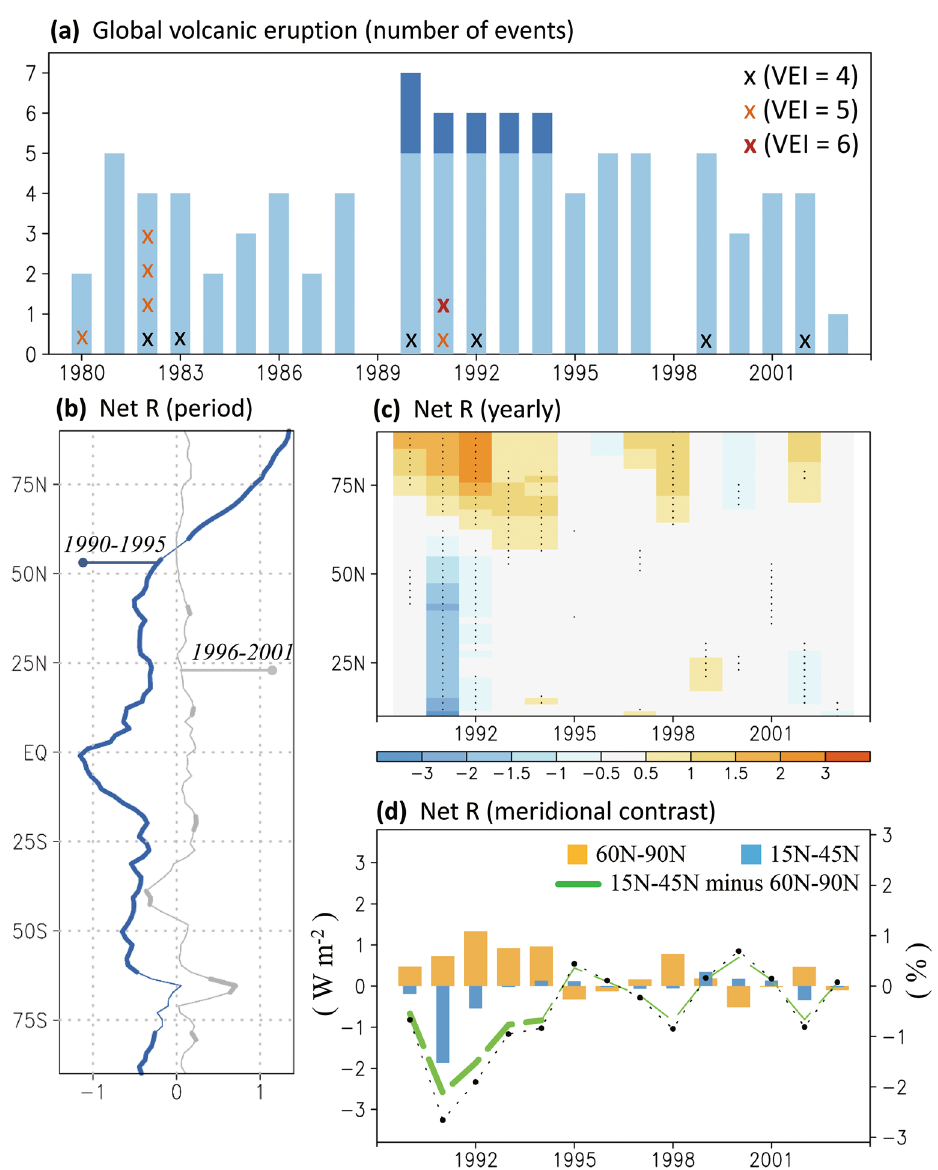
Figure 1. Radiative effects of decadal volcanic eruptions. ( a ) Number of yearly volcanic events globally (light blue bars; deep blue color denotes the frequency larger than five per year). Events with volcanic eruption index larger than three are counted and marked by x. ( b – d ) Volcanically induced zonal mean net radiative flux (W m −2 ) from December to February (DJF is defined by the year for December) at the top of the model, with the focus on ( b ) period average of 1990–1995 (blue line) and 1996–2001 (gray line), ( c ) year-by-year evolution, and ( d ) the Northern Hemispheric high (60° N–90° N, orange bars) versus middle (15° N–45° N, blue bars) latitudes; green dashed line denotes lower minus higher latitudes, and the black line with dots denotes the volcanic eruptions contribution (%) compared with control simulation. Thick lines and dots over shading denote that the difference had a confidence level of 90%. The Figure was generated using software Grid Analysis and Display System (GrADS) Version 2.1.1.b0 (http:// cola. gmu. edu/ grads/ grads.